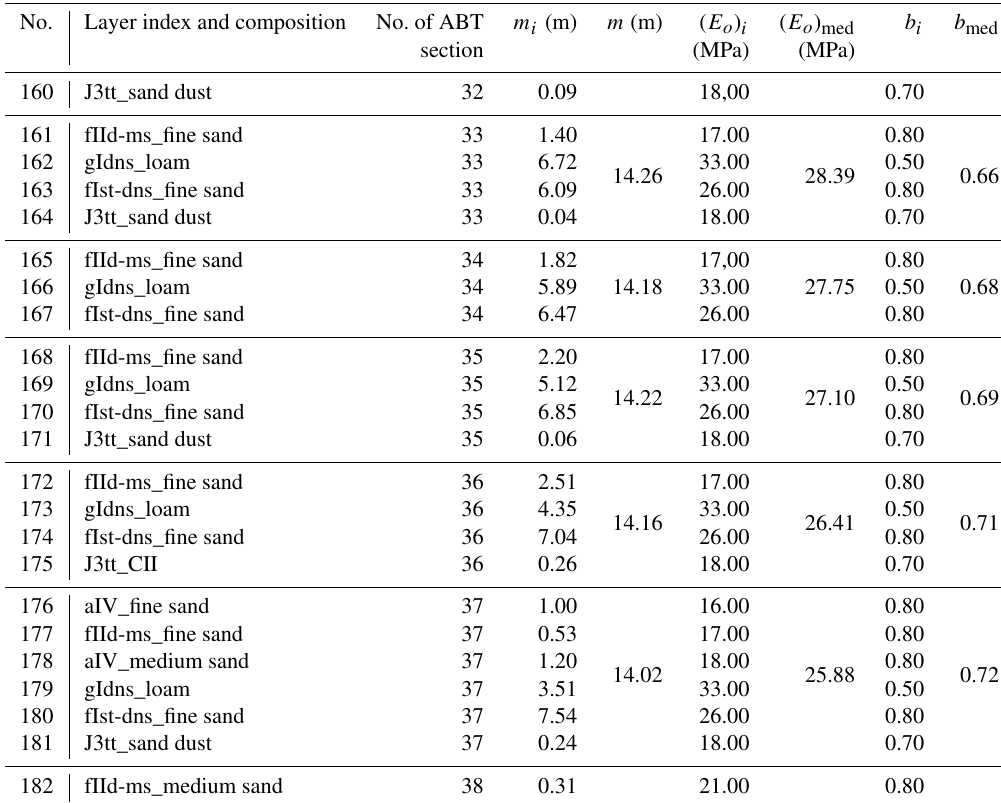
Table 1. Fragment of the table of data by the calculation layers and for the entire compressible massif model. No. Layer index and composition No. of